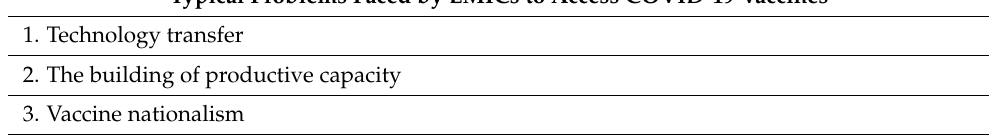
Table 3. Problems faced by